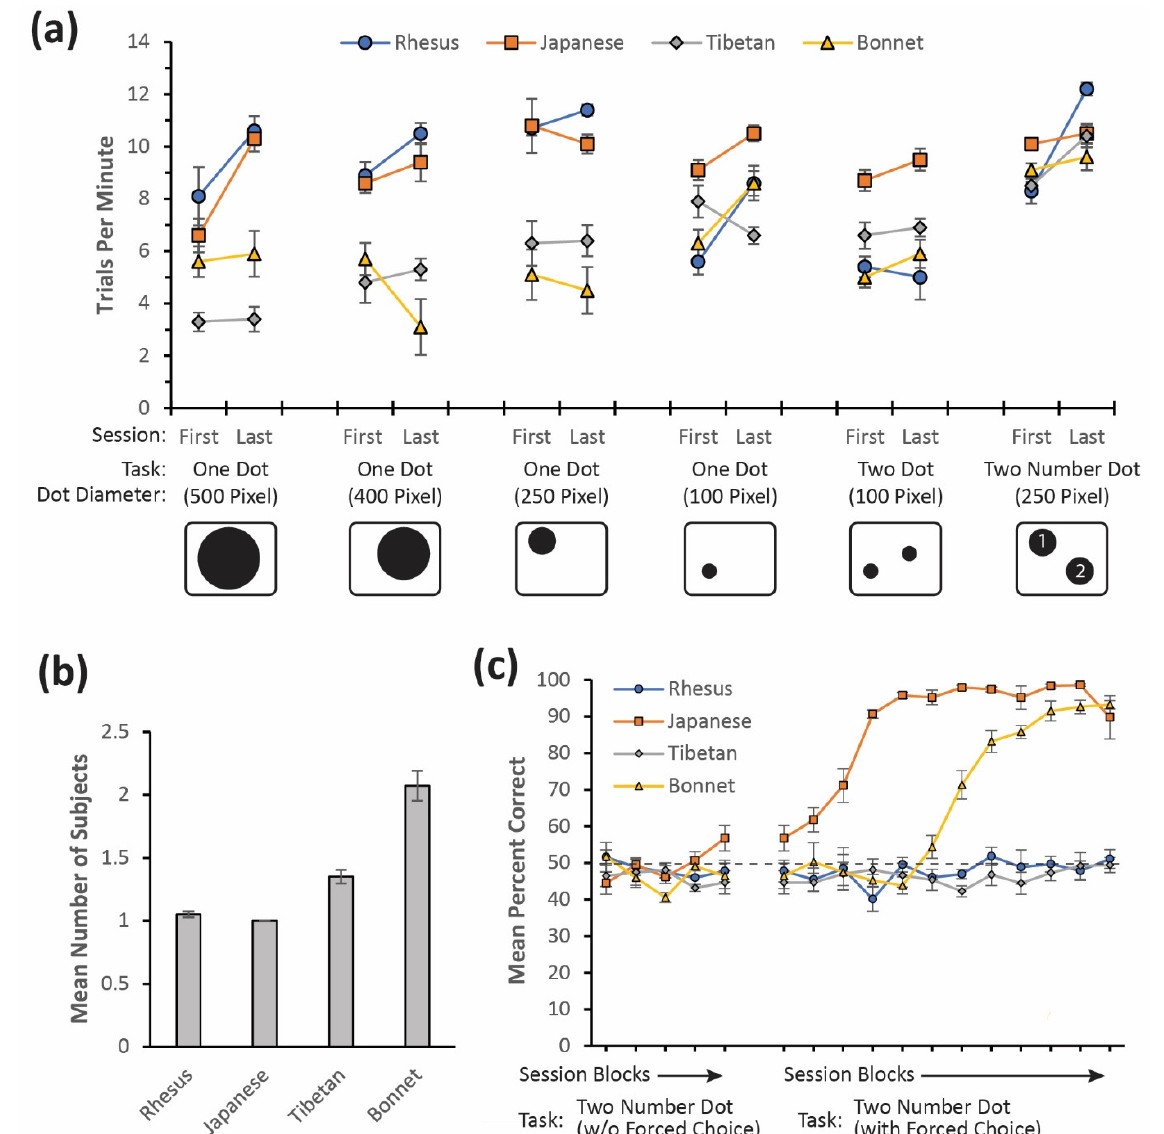
Figure 4. ( a ) Mean trials per minute for each group for the first and last session of each task. ( b ) Mean number of subjects that touched the screen for all sessions and tasks. ( c ) Performance rates on the Two Number Dot sequencing task. Blocks shown on the x -axis are composed of the five sessions each. Error bars show the mean standard error.